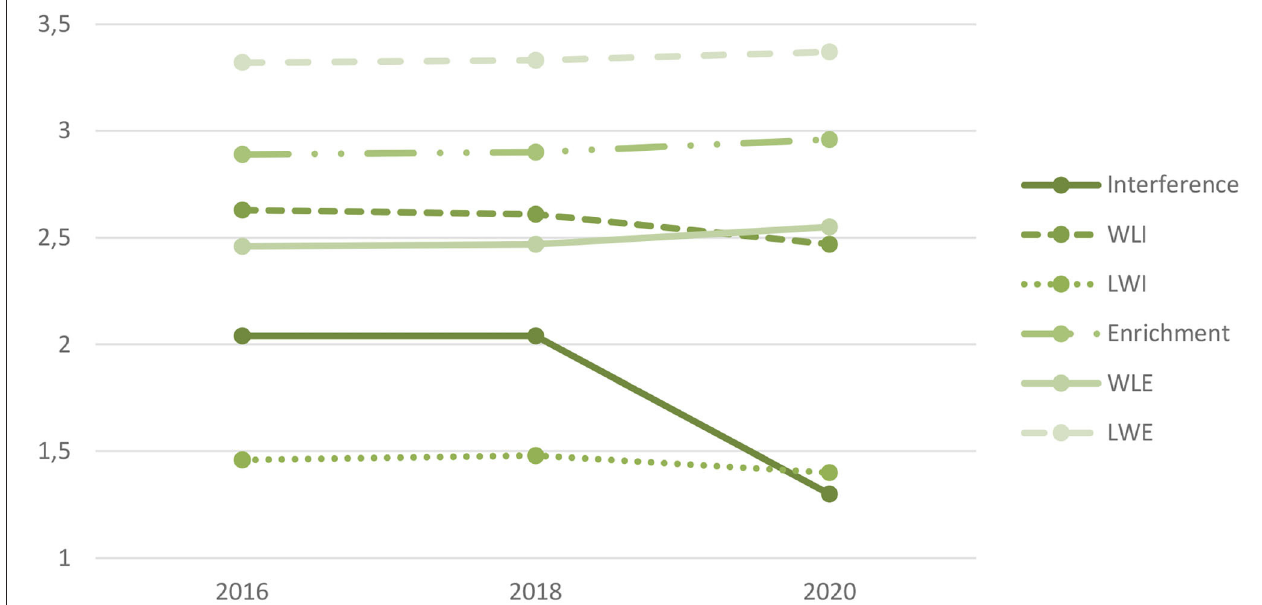
FIGURE 1 | Mean values for interference, WLI, LWI, enrichment, WLE, and LWE for the studied period.